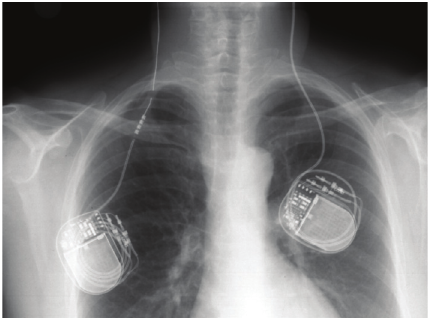
Figure 2: Lead fracture with connection located in thoracic region.